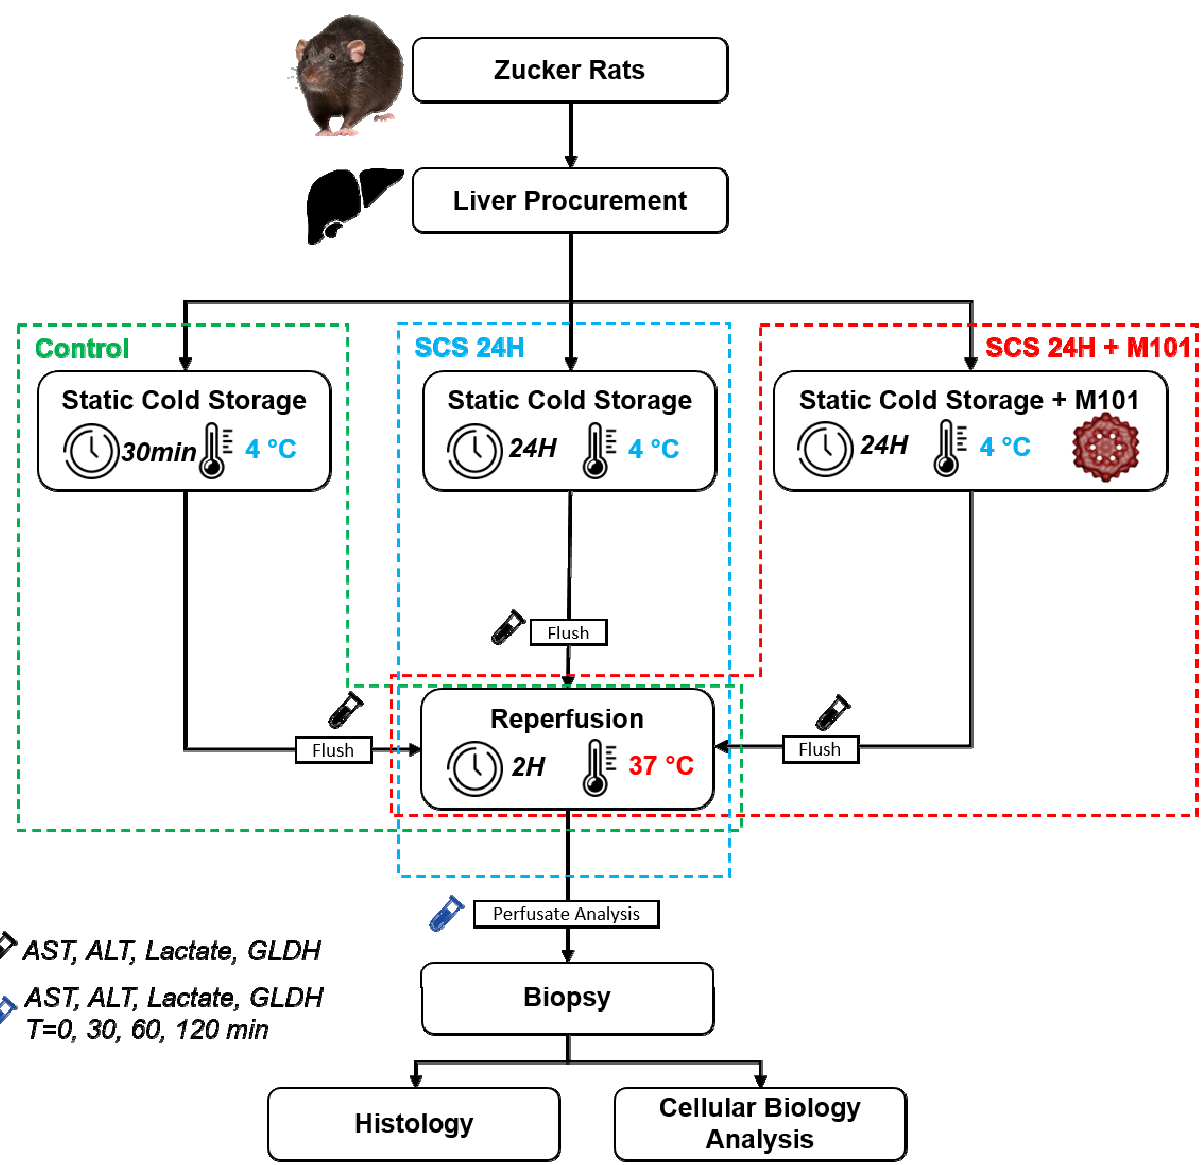
Figure 7. Schema experimental protocol. Rat livers were directly subjected to 30 min of static cold storage (control) followed by 2 h of normothermic reperfusion. Livers were rinsed with IGL-1 preservation solution supplemented (static cold storage (SCS-24H + M101 group) or not (SCS-24H group) with 1 g/L of M101, followed by 24 h of SCS and 2 h of reperfusion. At the end of the reperfusion, biopsies were taken and directly put into nitrogen ( − 80 °C) for cellular biology analysis (Western blot) or in PFA for histology. Perfusates were collected starting from the flushing (0 min) and at different time points during reperfusion (30 min, 1 h and 2 h).